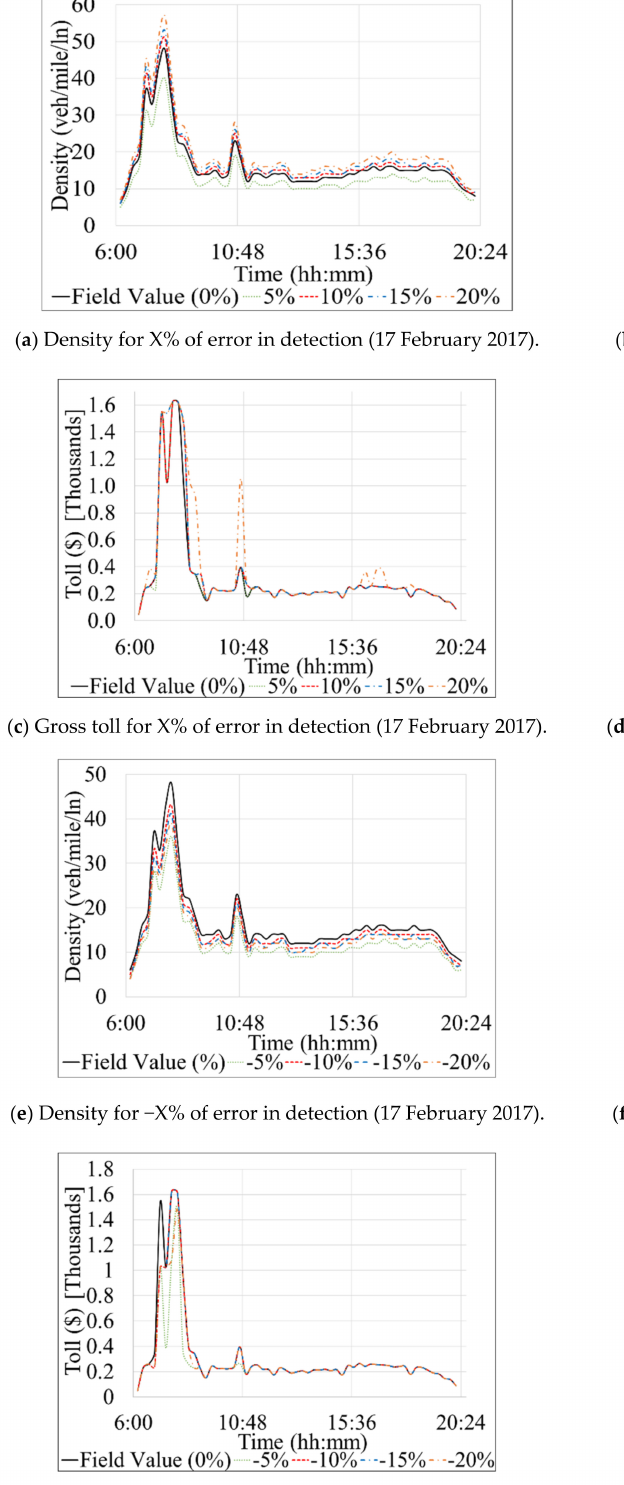
Figure 7. Diurnal fluctuations of density and 15-min gross tolls on Southbound